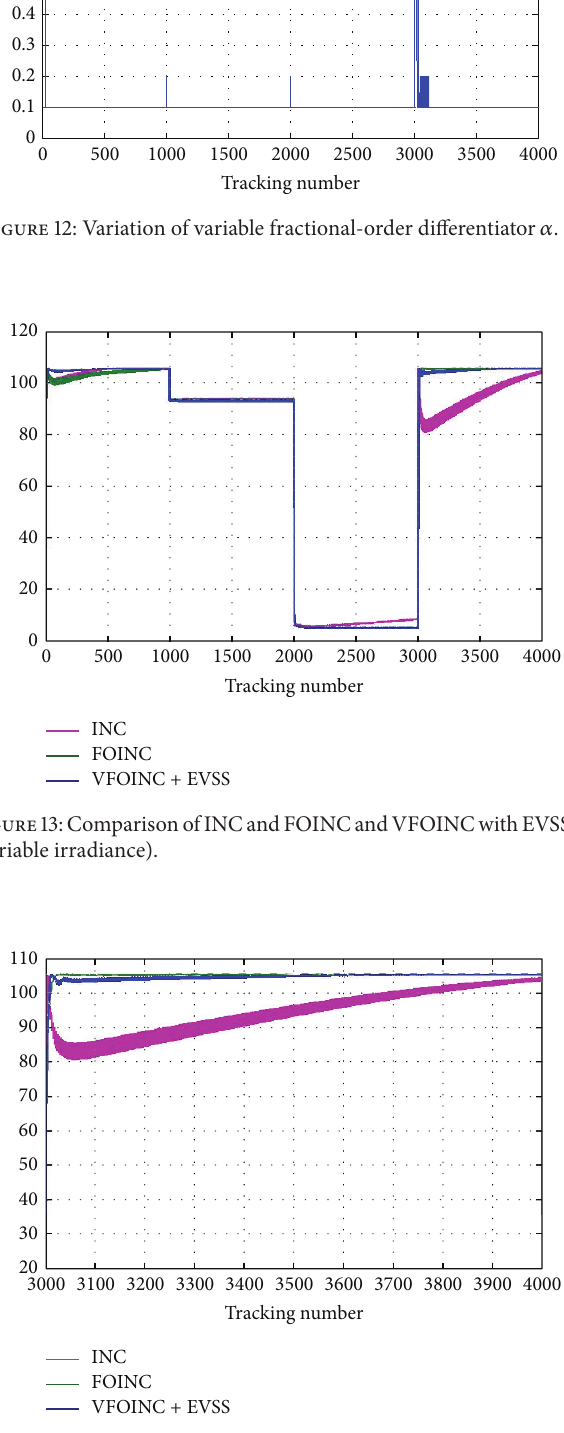
Figure 14: Comparison of INC and FOINC with VSS and VFOINC with EVSS (variable irradiance) (tracking number is 3000–4000).